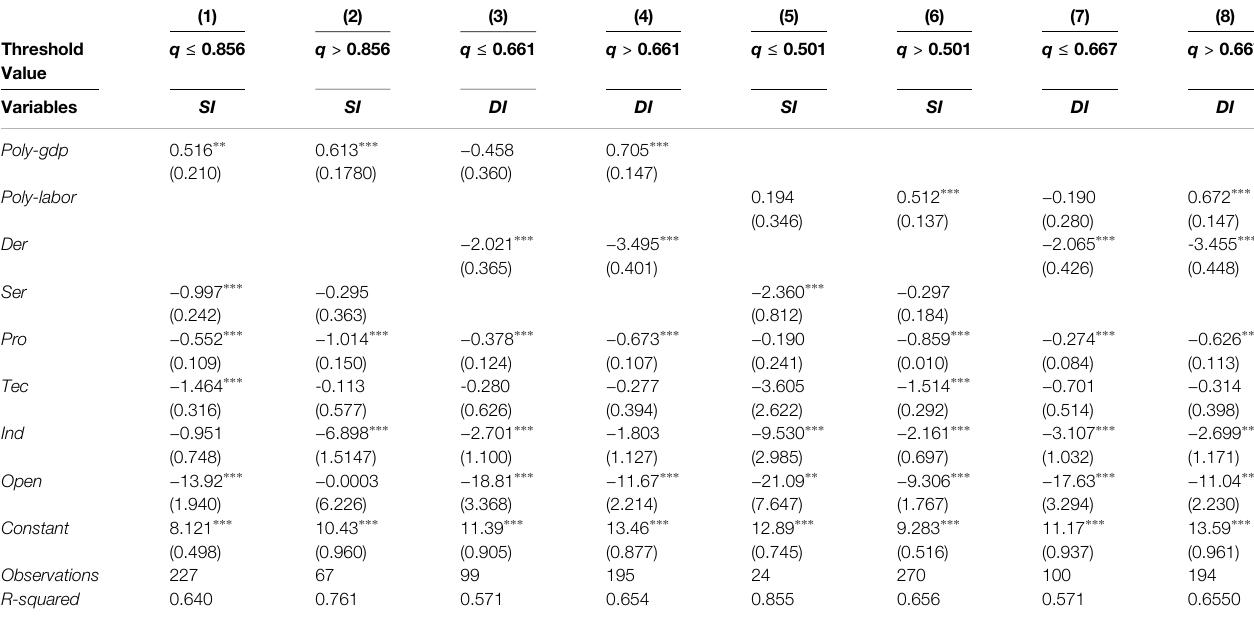
TABLE 5 | The threshold regression for the effect of spatial structure on pollution emission reduction in